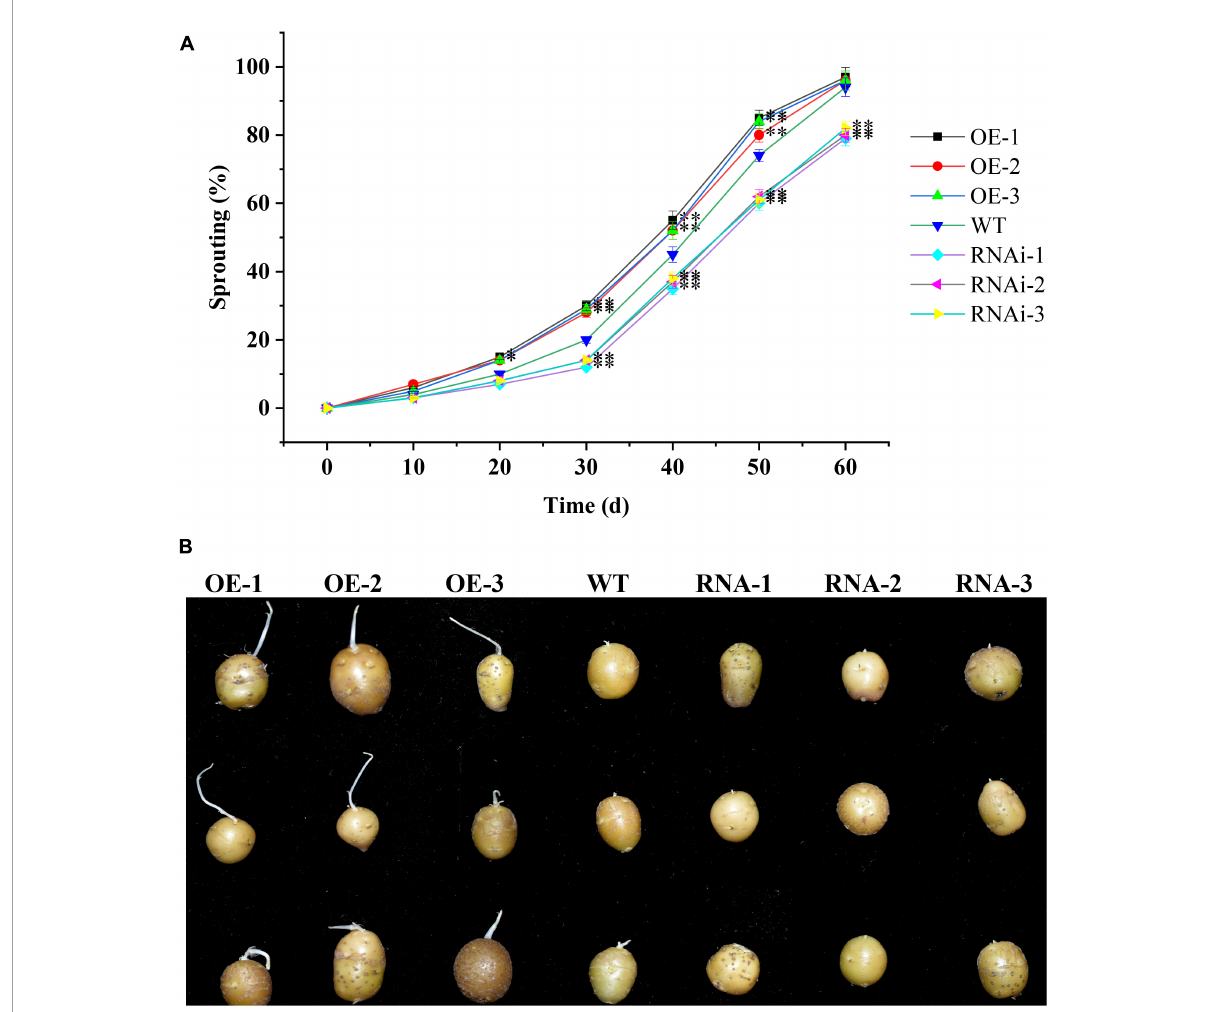
FIGURE4 StTCP15 promotes sprouting of potato tubers. (A) Sprouting percentages of StTCP15 transgenic and WT tubers. (B) Sprouting of transgenic tubers (partial) in 40 days. WT, Wild-type tubers of “Desiree”; OE-1 ∼ OE-3, Transgenic tubers of “Desiree” carrying recombinant plasmids pBI121-StTCP15; RNAi-1 ∼ RNAi-3, Transgenic tubers of “Desiree” carrying recombinant plasmids